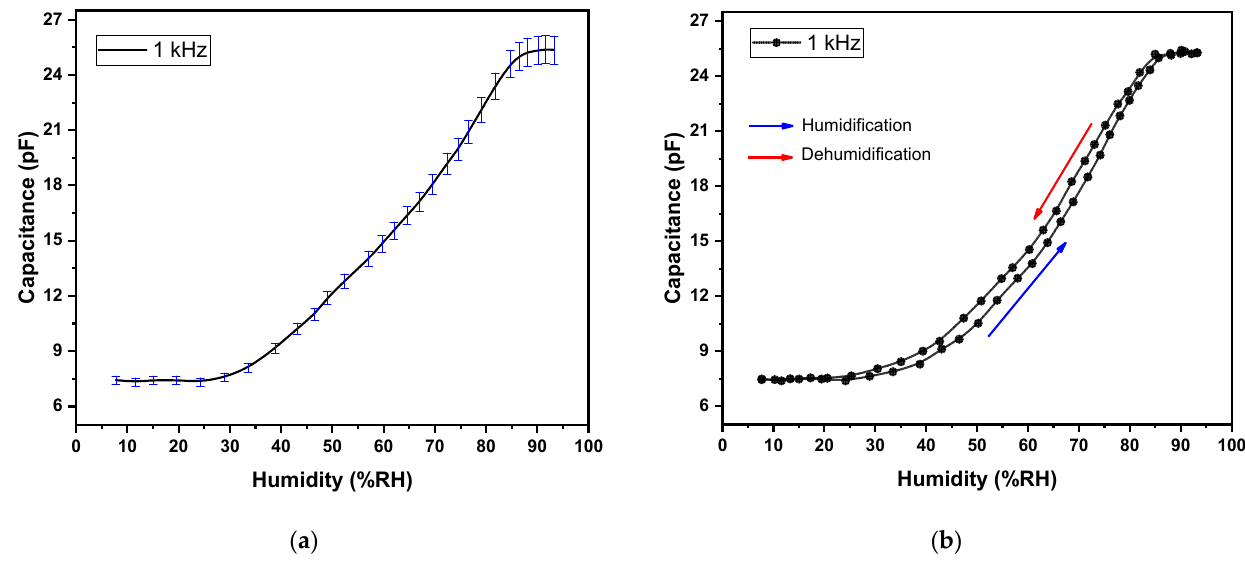
Figure 7. ( a ) Capacitance vs. relative humidity curve and ( b ) Hysteresis loop of Capacitance vs. relative humidity for Ag/F8-Cu 2 O/Ag sensor at 1 kHz.